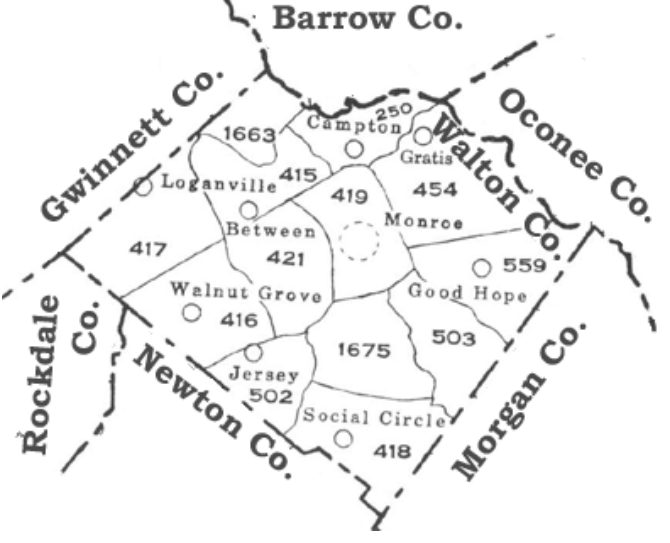
Figure 6. Walton Co., GA, Militia Districts (Georgia USGenWeb Archives Project, http://www. in GMD 503, 418, 502, and 416. GMD 283 of Morgan County joins GMD 418 and 503 of Walton County, and Hard Labor Creek flows through the area. Allen was taxed in GMD 502 in 1853 (the last tax digest entry located for him), at which time his sons lived in GMD 416 and 418. From the time he first appeared in Morgan County about 1809 until his death in 1863, Allen lived in a very small geographical area that spanned only about 14